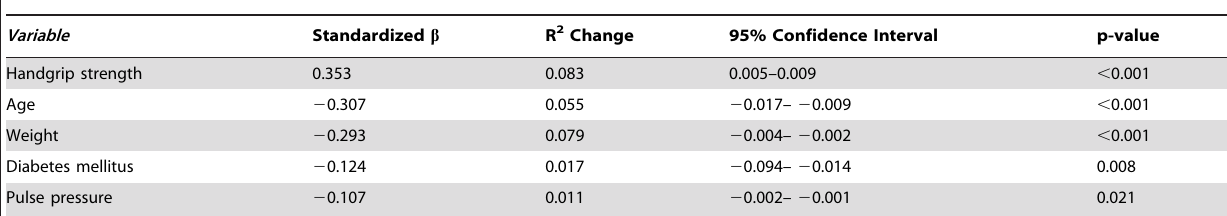
hypertensive participants taking b 1 -selective agents versus non- selective agents. Table 3. * Predictors of 400-meter gait speed.